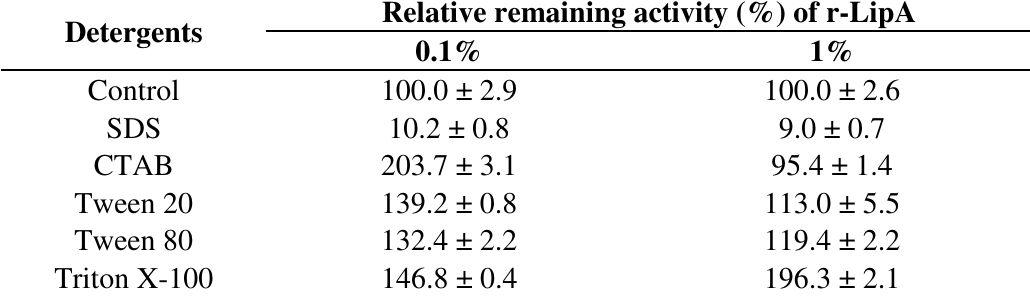
Table 2. Effects of various detergents on the activity of r-LipA. The reactions contained 0.1% or 1% (w/v) sodium dodecyl sulfate (SDS), cetyltrimethyl ammonium bromide (CTAB), Tween 20, Tween 80 or Triton X-100 and then the lipase activity was measured under standard conditions (30 °C, 10 min). The activity of r-LipA determined in the buffer with no addition of the detergents was set as 100%. Values are means ± SD from three independent